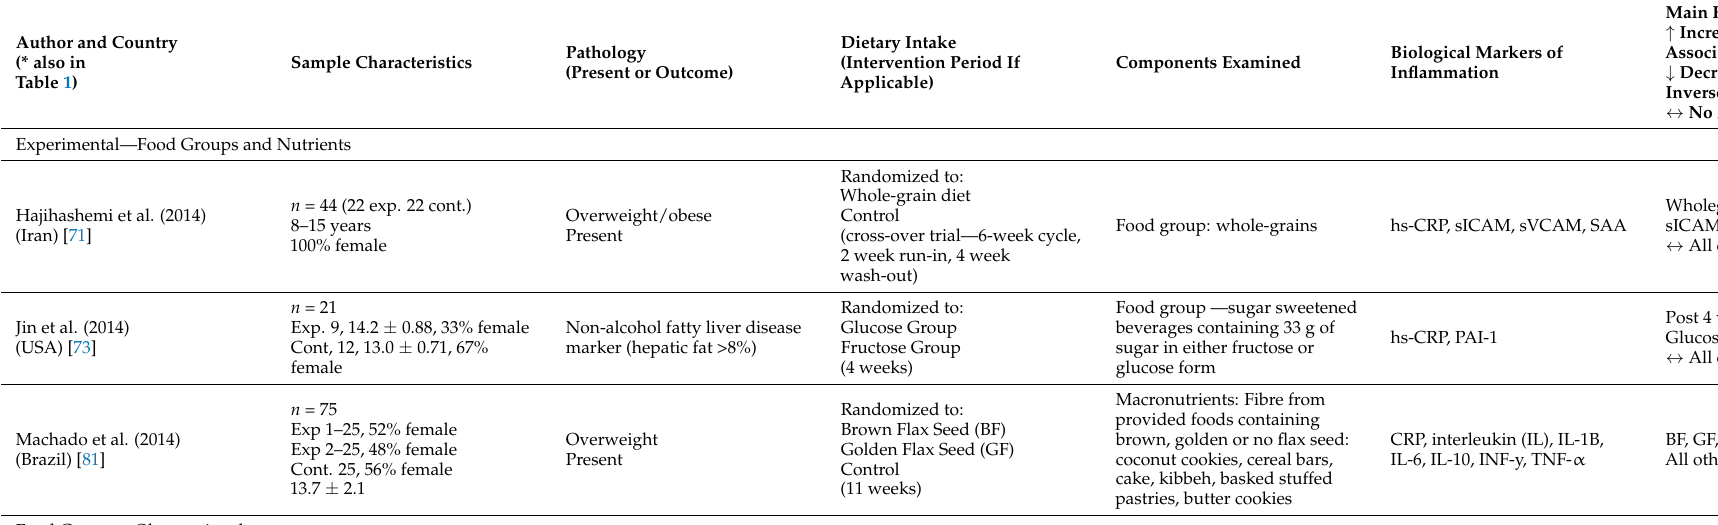
Author and Country (* also